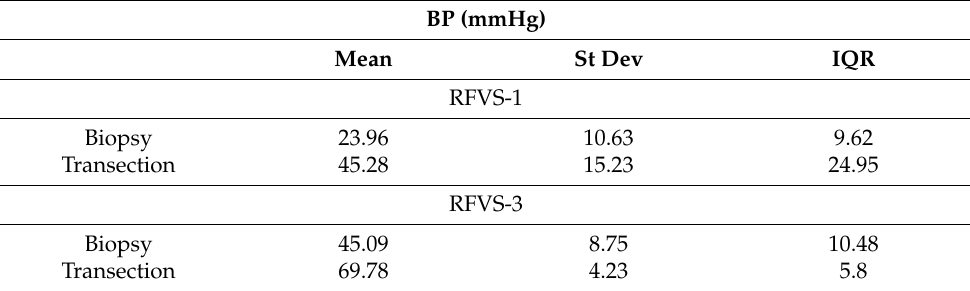
Table 4. Comparison of maximum BP pressure in mmHg obtained in the two-study